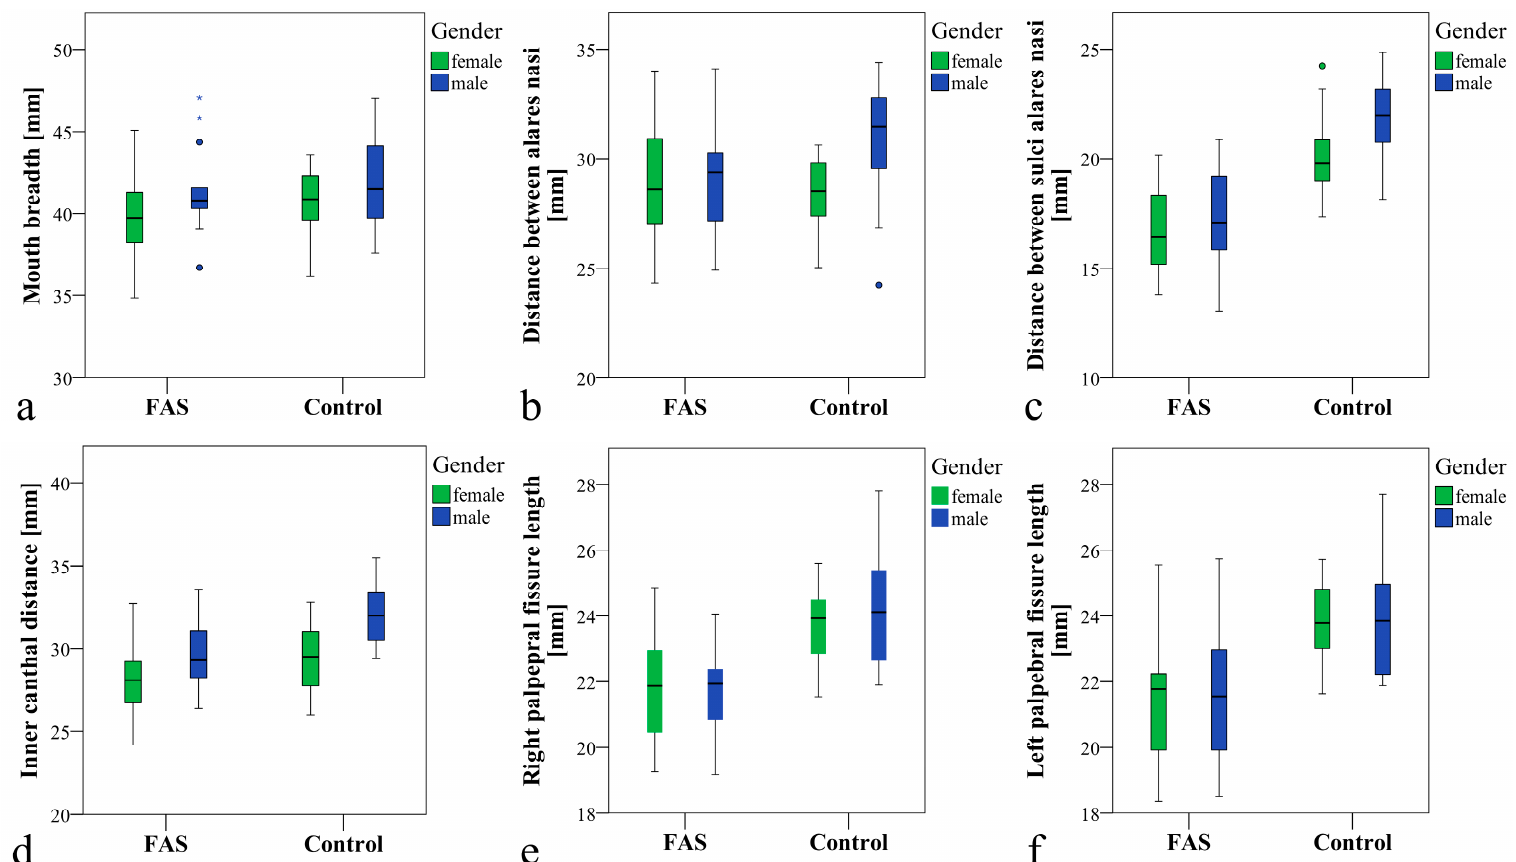
Figure 2. Boxplots showing respective distances for groups and gender; non-significant ( a – b ) and significant ( c – f ) differences between children with FAS and the control children for total groups and gender specific comparison, except for d where no significant difference could be found for FAS- versus control-females. While there were no significant gender differences within the FAS group, significant gender differences for the control children could be found ( b – d ).